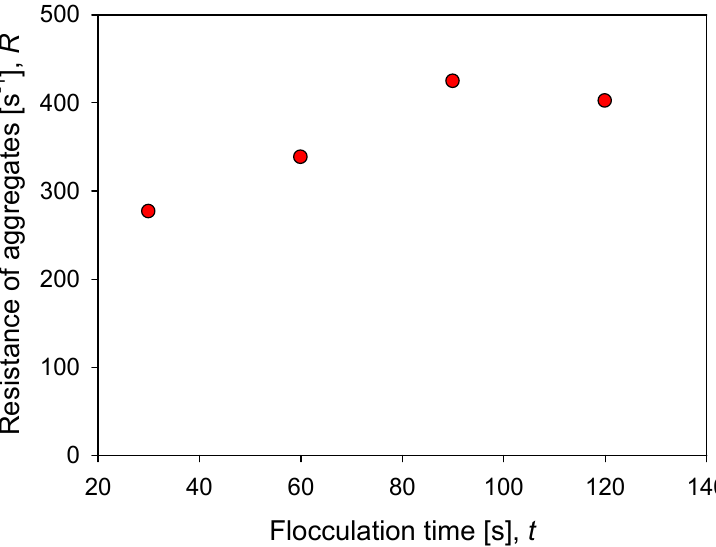
Figure 8. Effect of flocculation time on the resistance of kaolin aggregates ( R ) flocculated in SW with 89 g/t of flocculant.